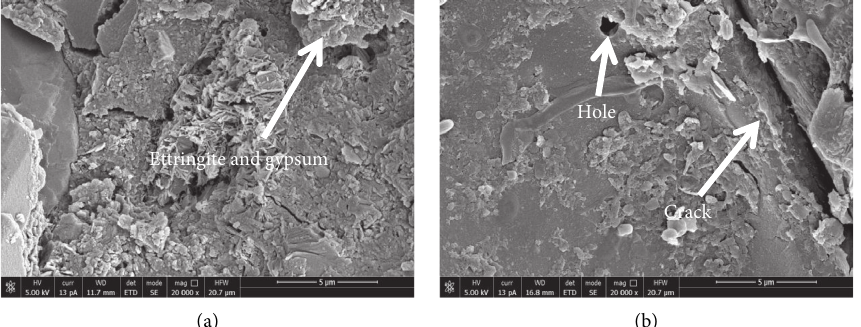
Figure 12: The microstructure of ordinary concrete under sulfate erosion environment. (a) Dry-wet cycle 45 times. (b) Dry-wet cycle 90